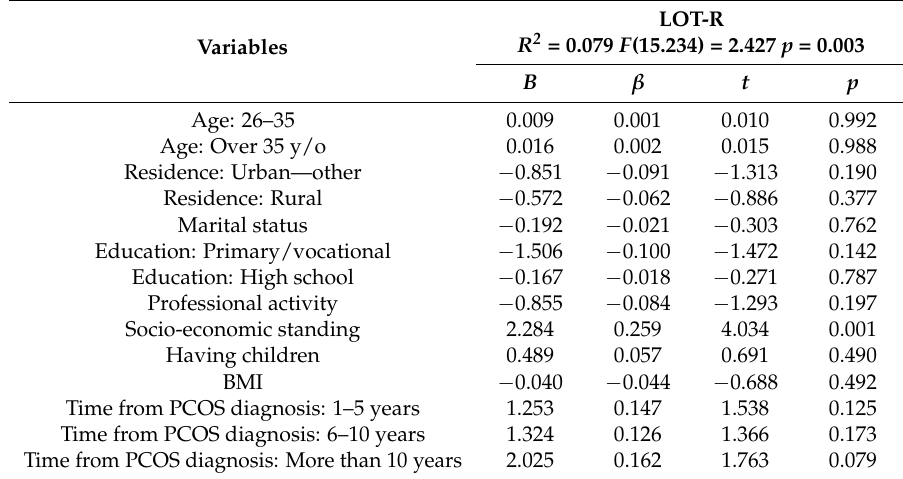
Table 4. Regression model for variables LOT-R.